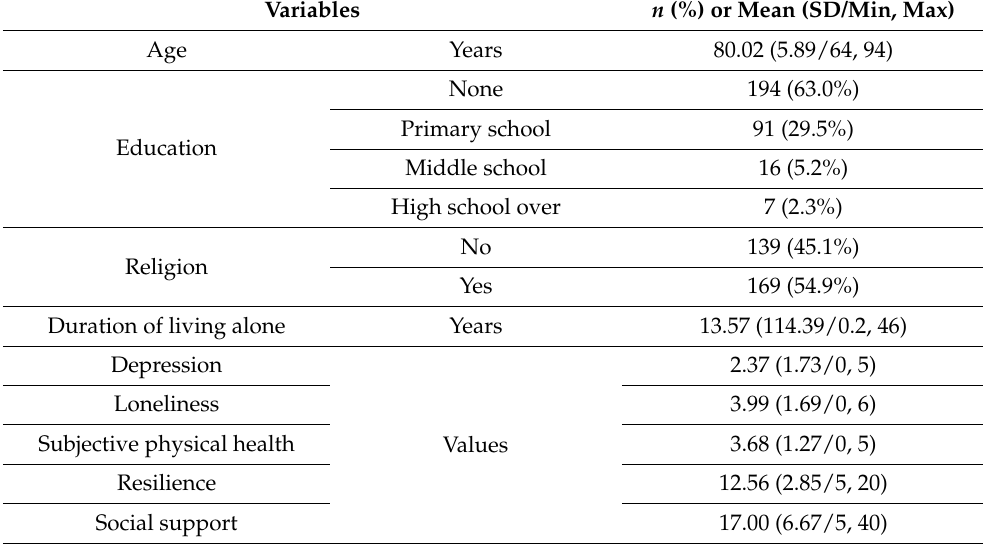
Table 1. Descriptive statistics of the study population ( n = 308).